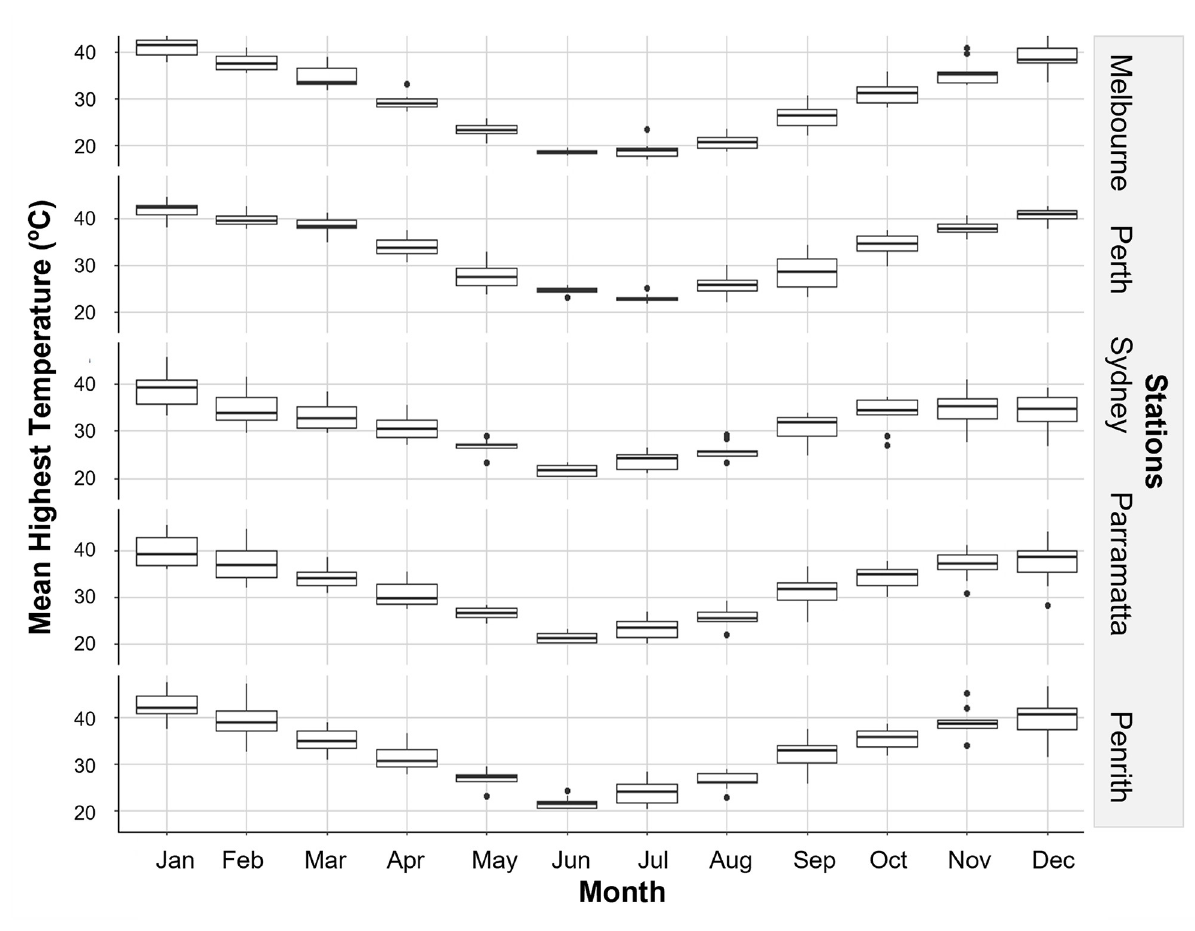
Fig 5. Trend in mean monthly highest temperature from 2009 to 2019 at sampling